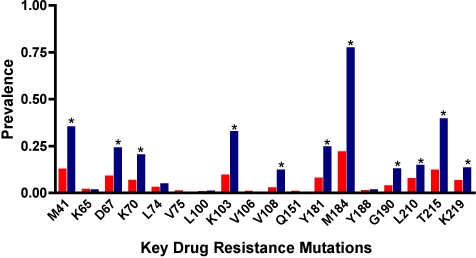
Association of N348I with Key Drug Resistance MutationsThe prevalence of key drug resistance mutations without N348I (red bars) compared to their prevalence with N348I (blue bars). The last on therapy sample from a total of 3,569 patients was analysed where 3,408 and 161 samples did not or did contain N348I, respectively. Statistically significant differences between the two groups were determined by Chi-square analysis. The asterisk above the bars denotes p < 0.001, except for L210 where p = 0.002.